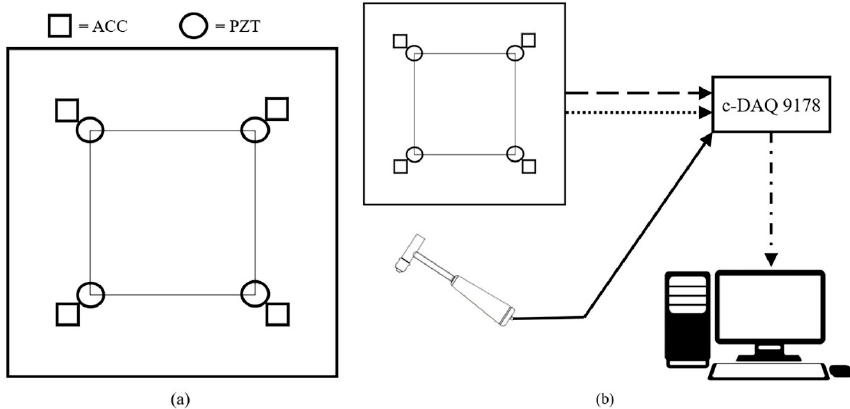
Figure 1. Impact area and sensor positions ( a ) and experimental setup ( b ).